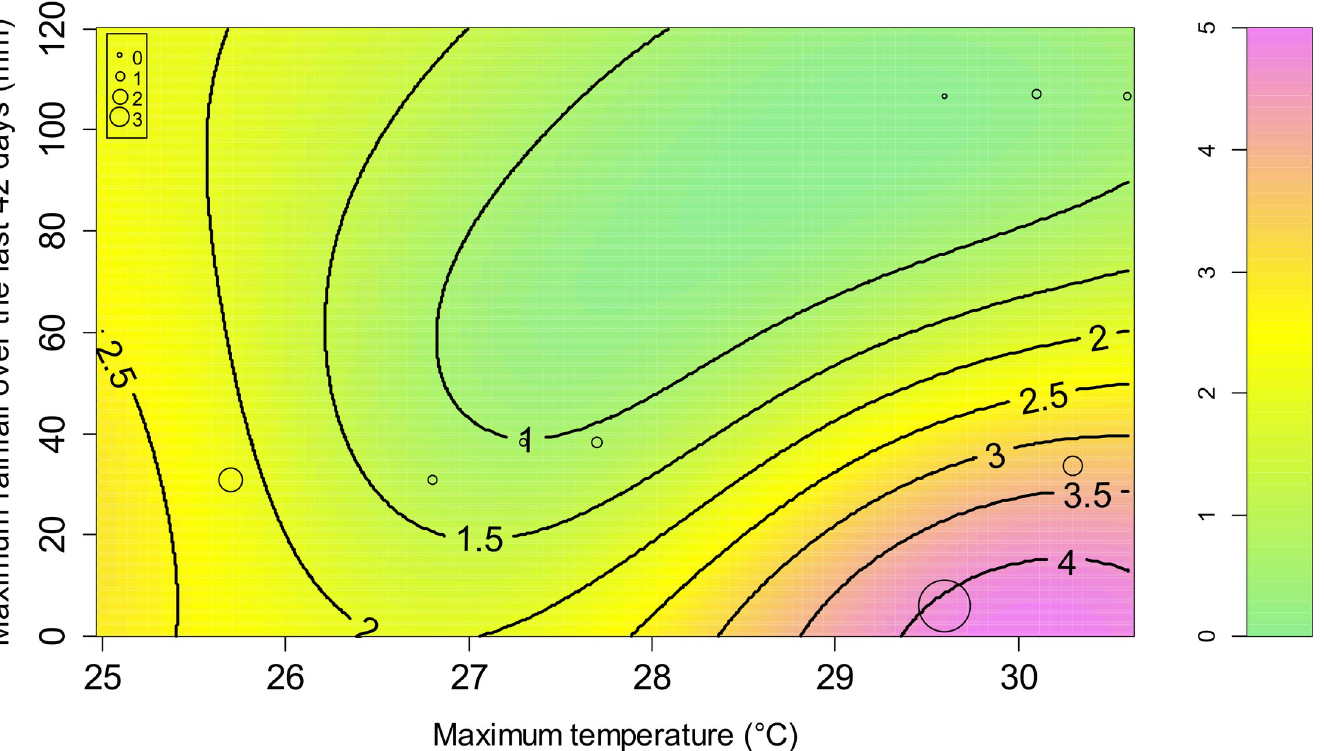
Fig 4. Prediction of the Xenopsylla Genus Flea Index (GFI) according to two variables related to two meteorological variables: the maximum temperature and the maximum rainfall over the last 42 days. The colors and level lines represent the model predictions. The circles correspond to the observations.